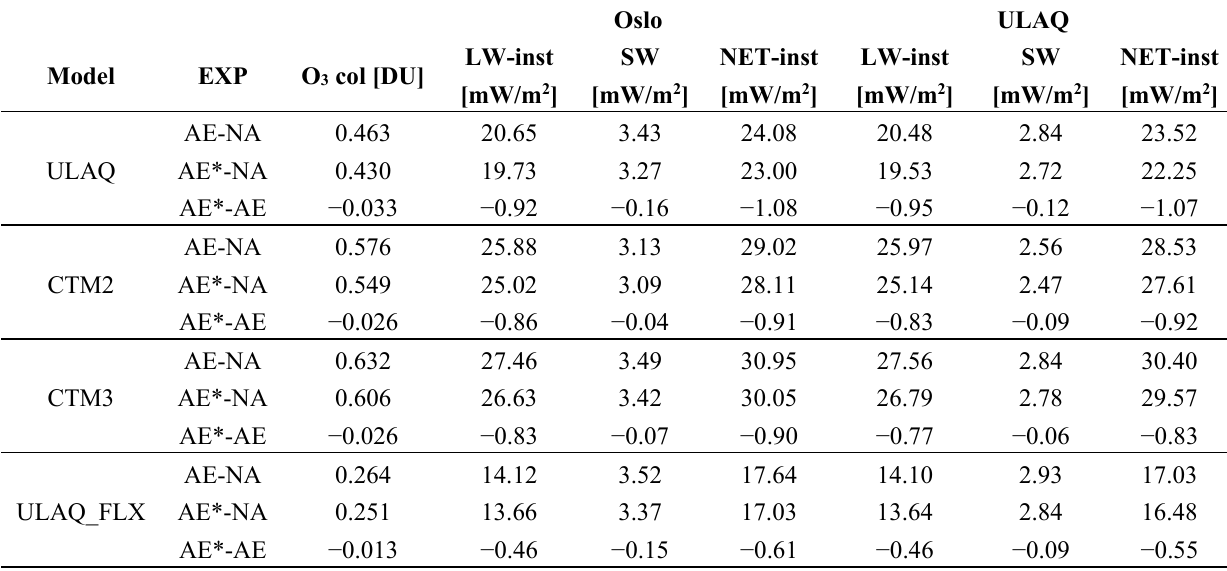
Table 3. Summary of O 3 RF mean values for clear sky conditions. Differences are calculated between NA (experiment with no aircraft emission), AE (experiment with only gaseous emission [NO x +H 2 O]) and AE* (experiment with gaseous and particle emission [NO x +H 2 O+SO 4 ]). RF values are calculated with Oslo and ULAQ radiative code at ECMWF and National Center for Environmental Prediction (NCEP) tropopause level, respectively. LW, SW, NET are longwave, shortwave and net RFs, respectively. Only LW instantaneous values are considered here.